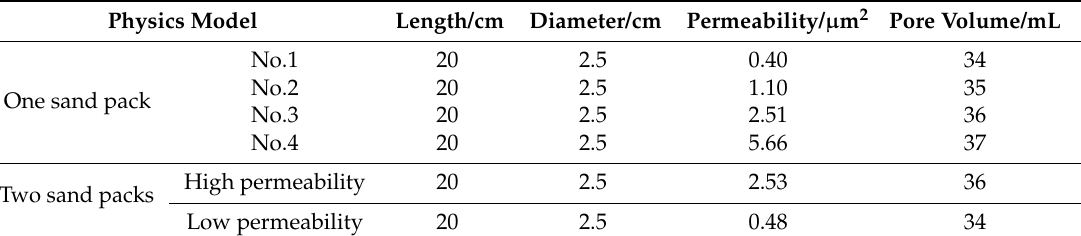
Table 2. Parameters of the sand pack physics